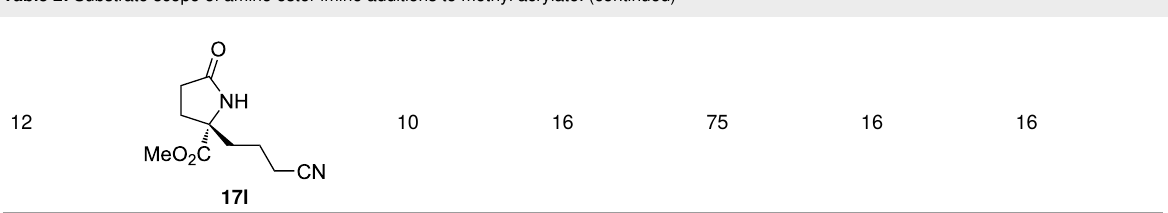
Table 2: Substrate scope of amino ester imine additions to methyl acrylate. (continued)